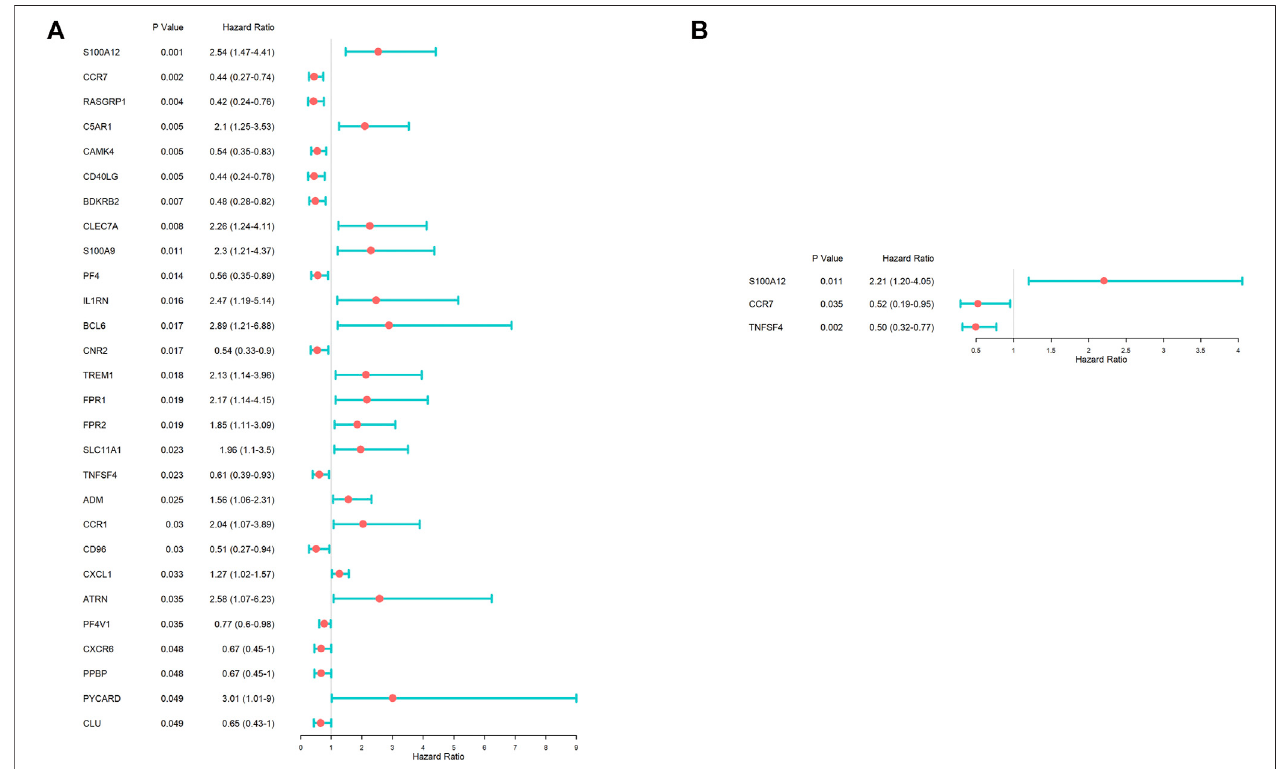
FIGURE 2 | Identi fi cation of prognosis-associated in fl ammation-related genes according to Cox regression analysis. (A) Univariate Cox regression analysis. (B) Multivariate Cox regression analysis.